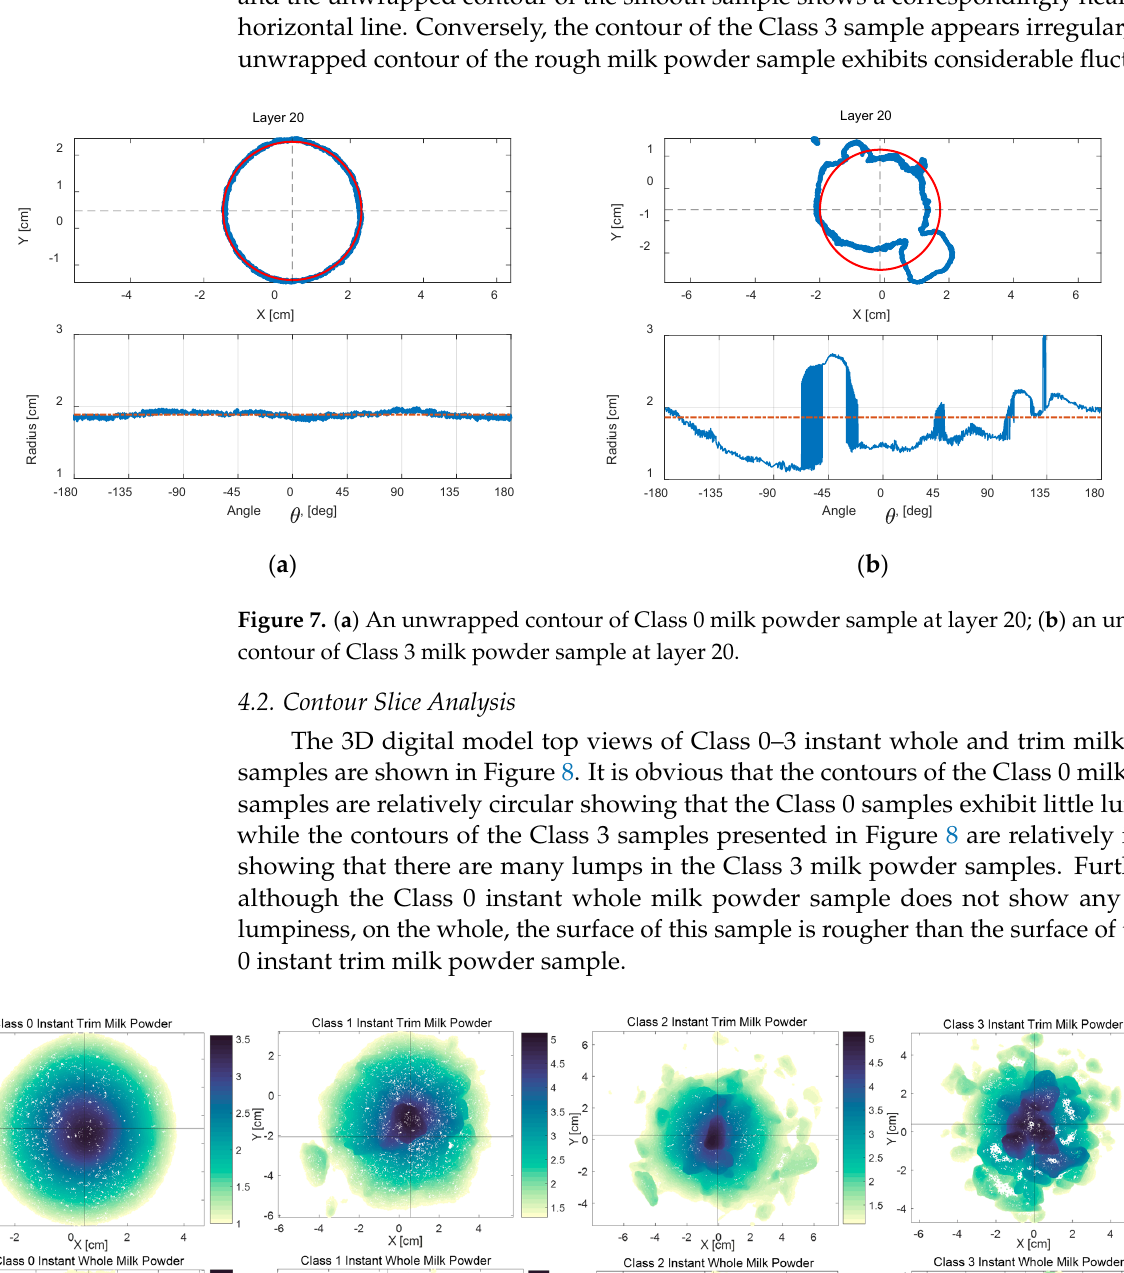
Figure 6. An 3D reconstruction triangular mesh model of a milk powder sample.